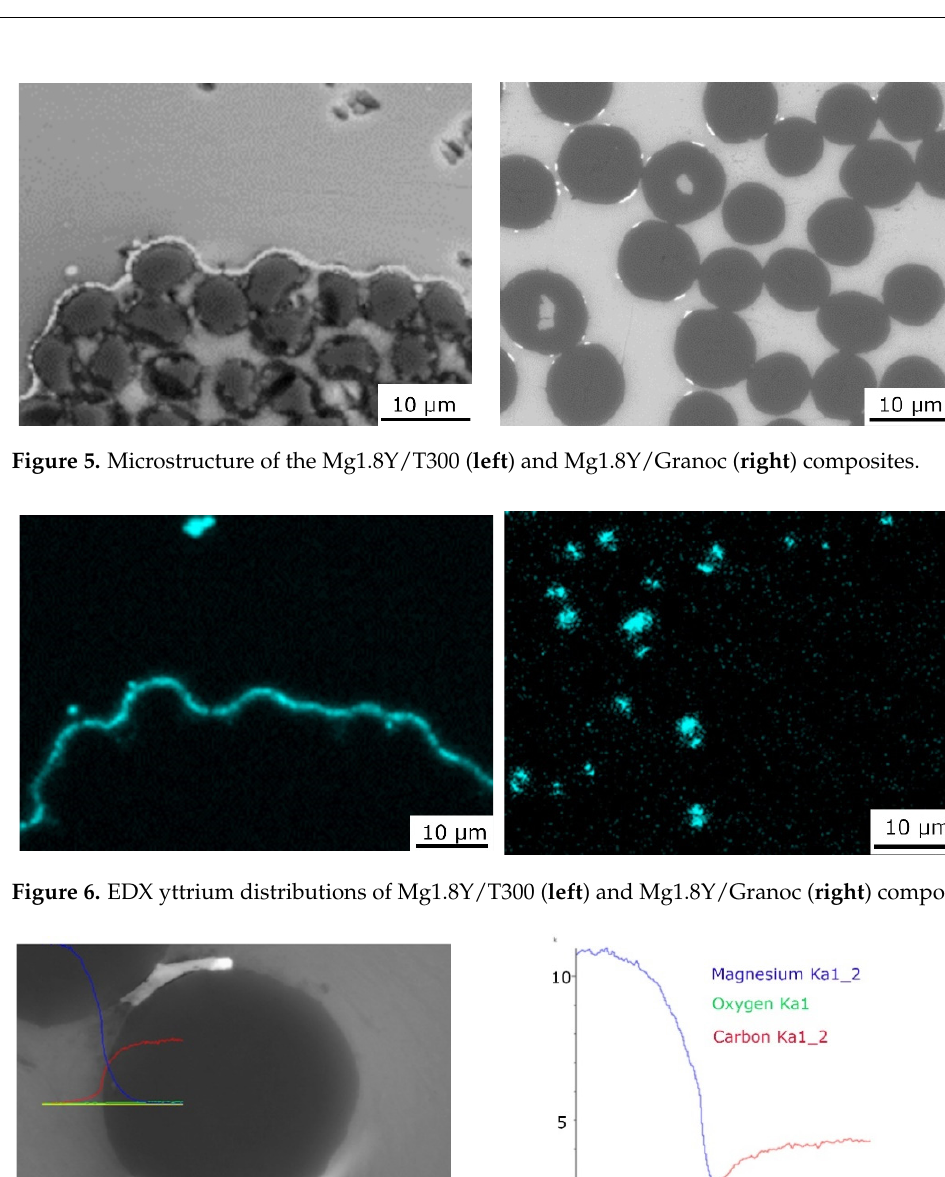
Figure 6. EDX yttrium distributions of Mg1.8Y/T300 ( left ) and Mg1.8Y/Granoc ( right ) composites.